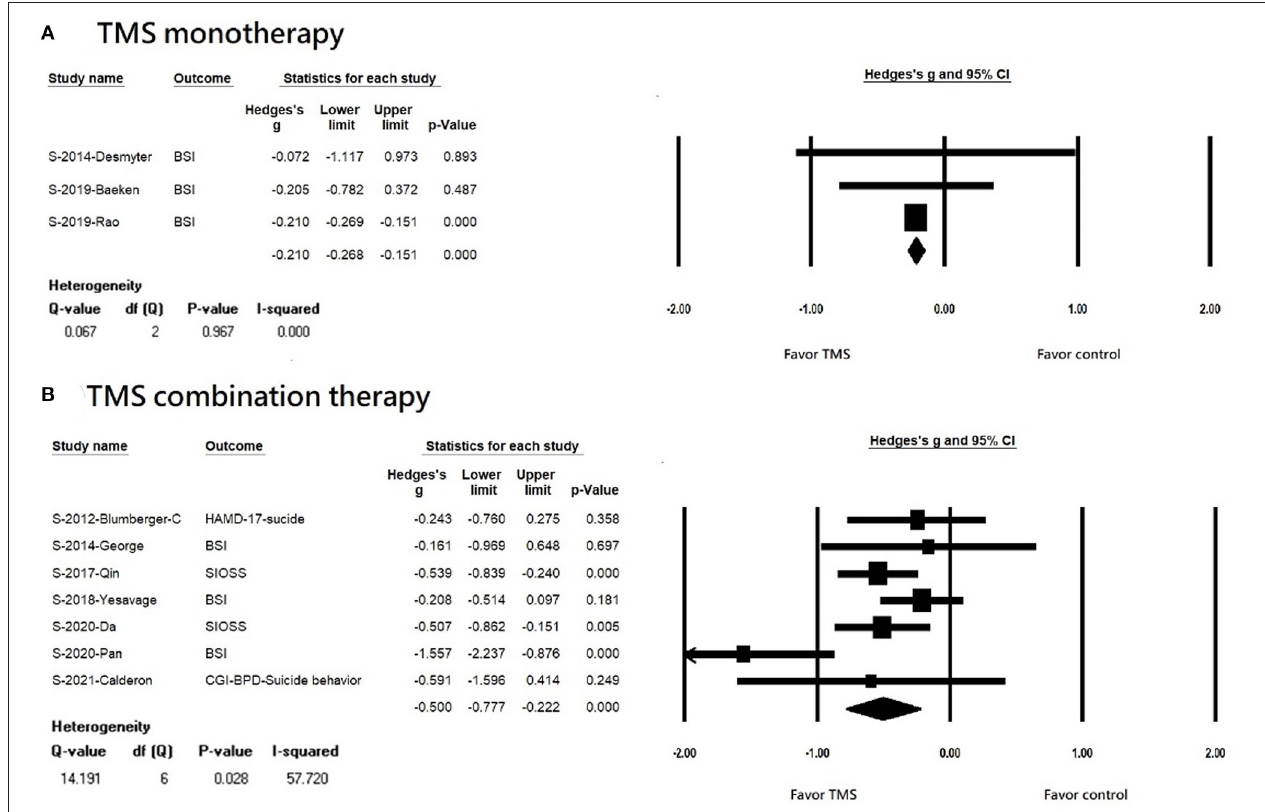
FIGURE 4 | (A) Forest plot of meta-analysis of improvement of suicidal ideation in patients receiving repetitive transcranial magnetic stimulation monotherapy and in those with control treatment. (B) forest plot of meta-analysis of improvement of suicidal ideation in patients receiving repetitive transcranial magnetic stimulation combination therapy and in those with control